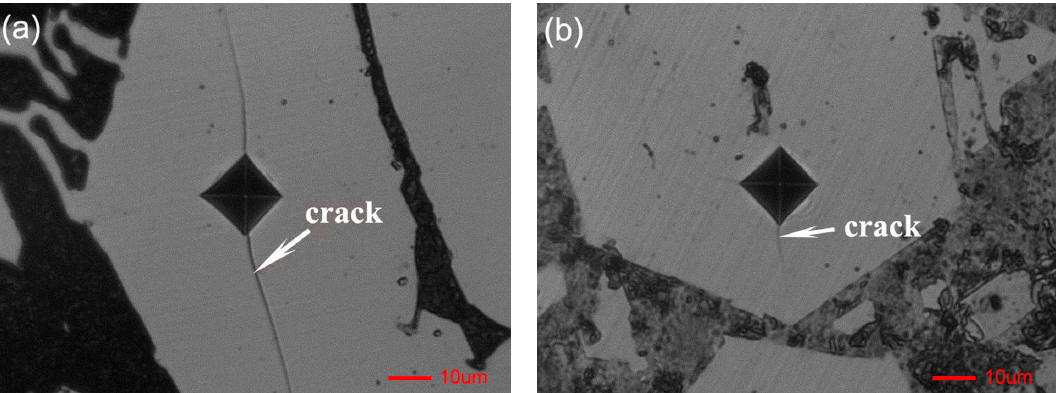
Figure 6. The micro-indentation on the surface of primary carbides: ( a ) Non-ECP sample; ( b ) ECP sample.